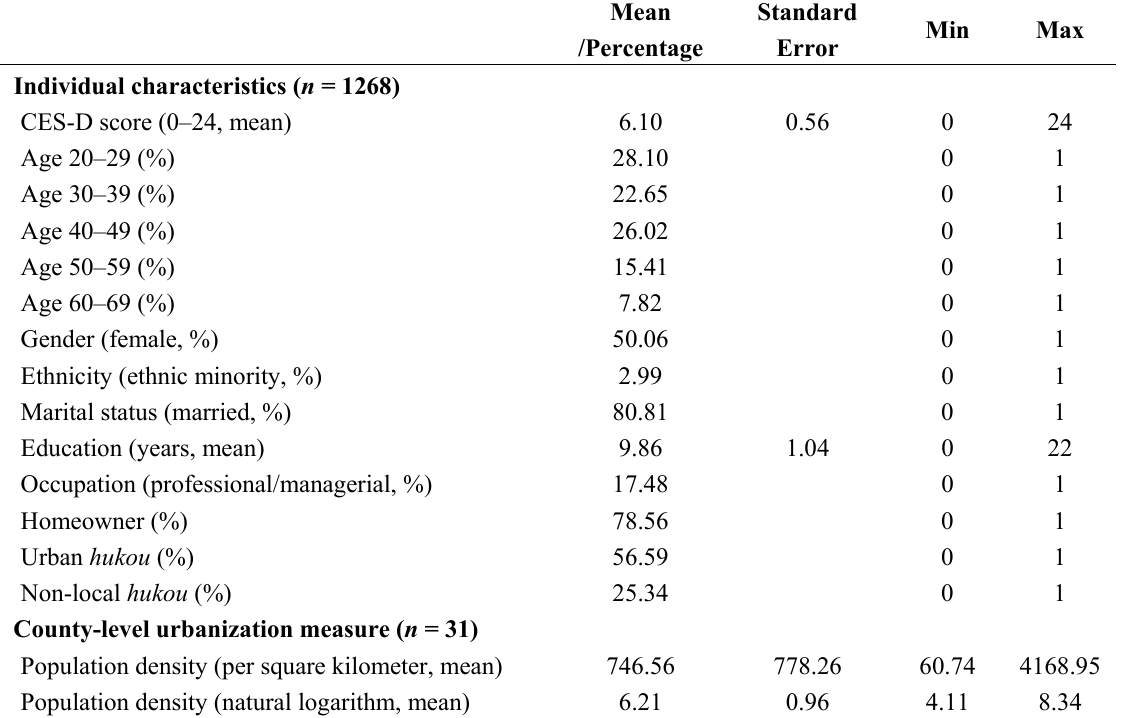
Table 1. Descriptive statistics of individual characteristics and county-level urbanization measure.